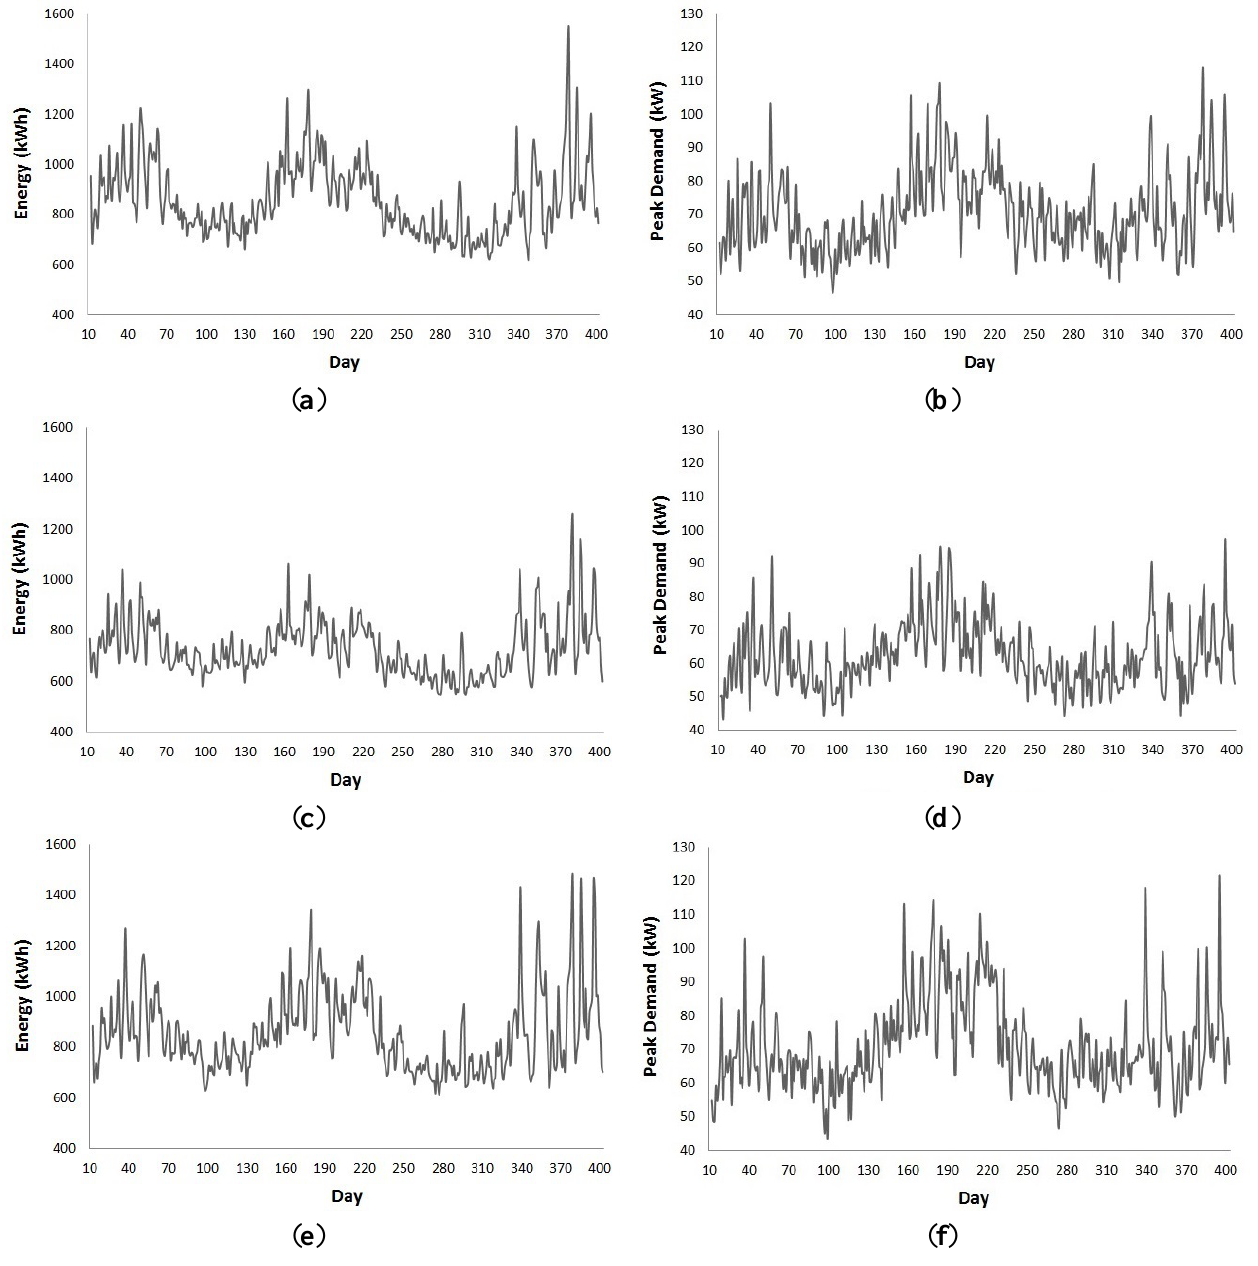
Figure 1. Daily total electricity demand data and daily peak demand data: ( a ) Phase 1: daily total energy use; ( b ) Phase 1: daily peak demand; ( c ) Phase 2: daily total energy use; ( d ) Phase 2: daily peak demand; ( e ) Phase 3: daily total energy use; and ( f ) Phase 3: daily peak